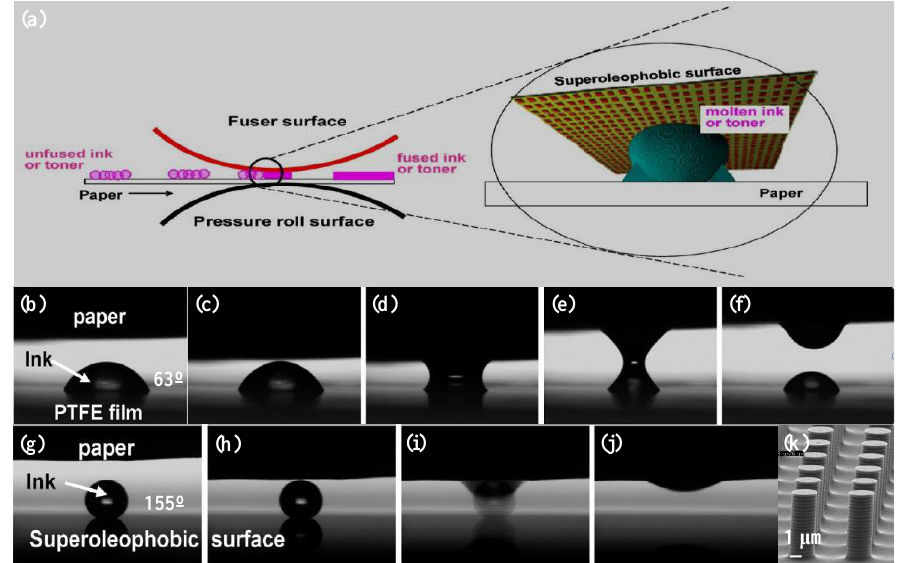
Figure 13. ( a ) Basic principle of the fuser with the superhydrooleophobic surface. ( b – f ) Illustration of the interaction between paper and molten ink droplets on an oleophilic PTFE substrate during the printing process. Part of the ink was left behind on the PTFE film and not completely printed onto the paper ( f ). ( g – j ) Illustration of the interaction between paper and molten ink droplets on superoleophobically textured silicon pillars. Ink was completely printed onto the paper ( j ). ( k ) shows the textured superoleophobic pillar arrays used in the printing process [73]; reproduced with permission from the American Chemical Society.